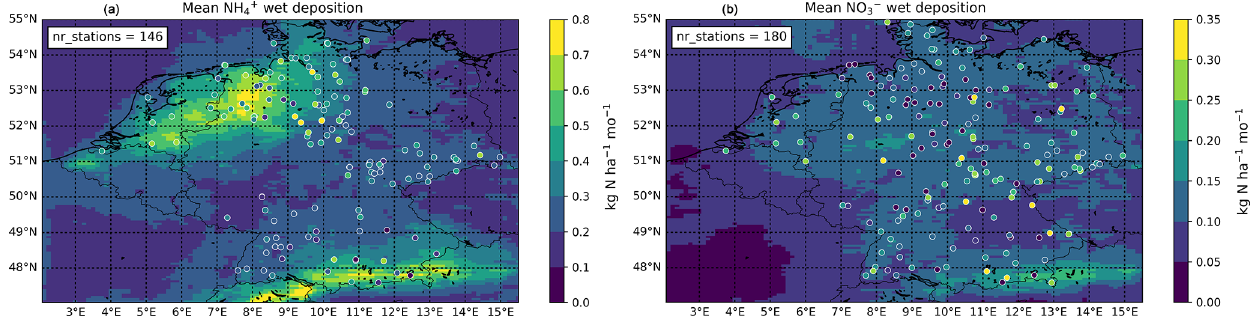
Figure 16. The mean NH + (a) and NO − (b) wet deposition in kgNha − 1 month − 1 in 2014. The mean observed wet deposition observed at 4 3 the stations is plotted on top.